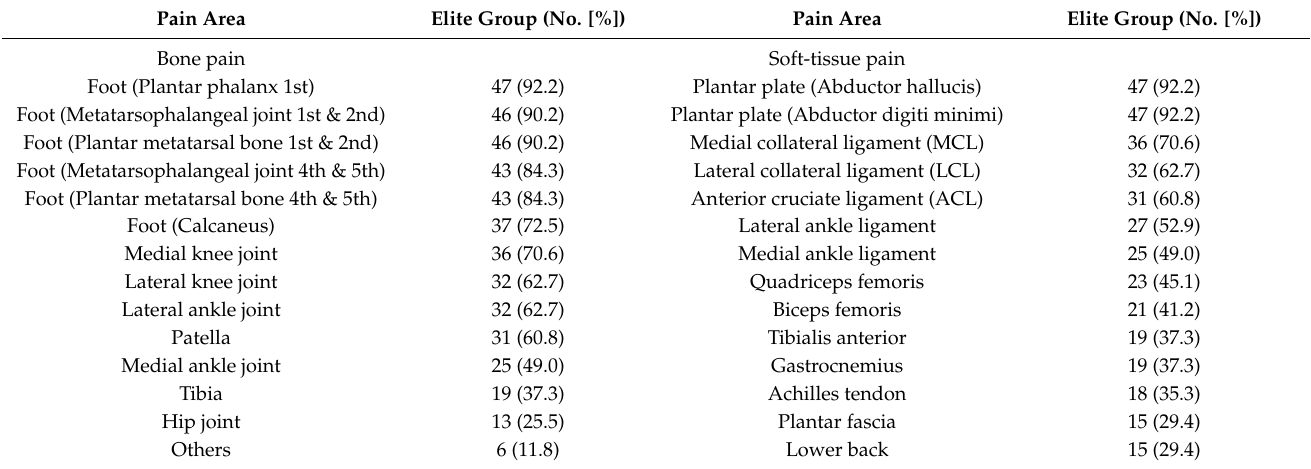
Table 6. Pain Assessment and Self-Reported Health Status in the 51 Elite Rugby